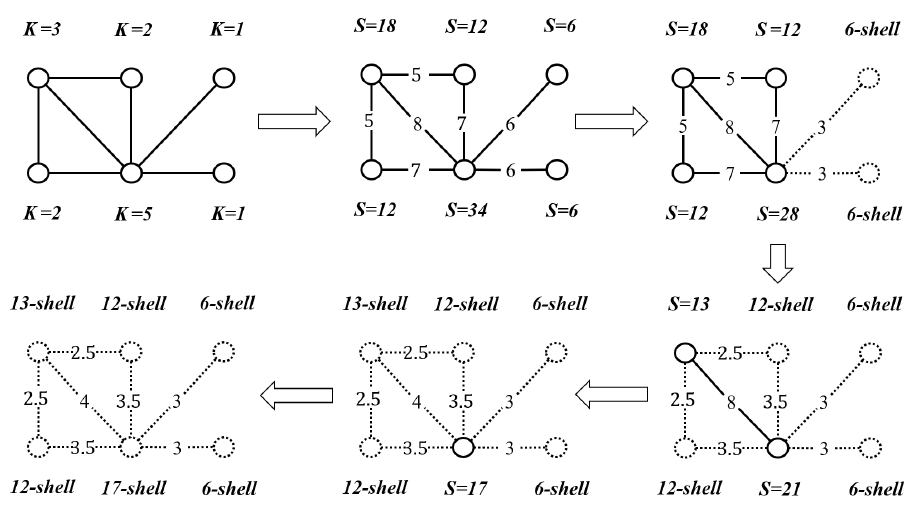
Figure 2. A sample to illustrate the procedure of DNSD. The nodes with dashed nodes are the removed nodes and the edges with dashed line are the vanishing edges and